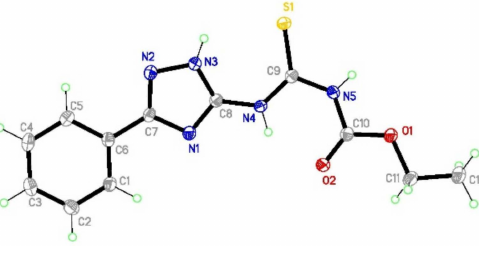
Figure 1. X-ray structure of 17